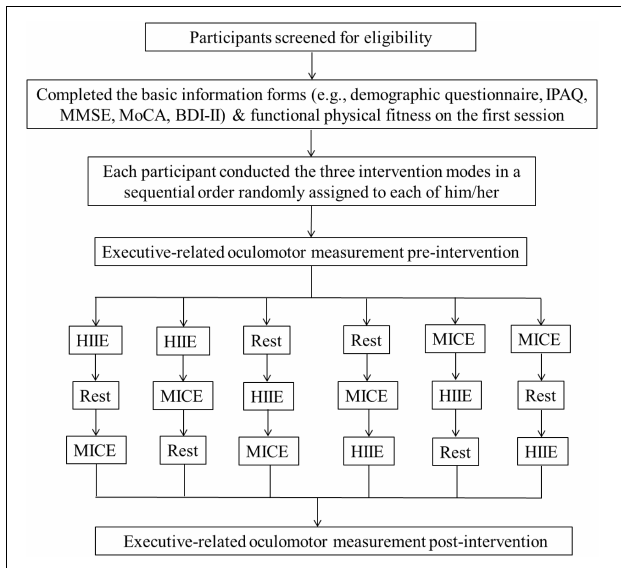
FIGURE 1 | Flowchart of the